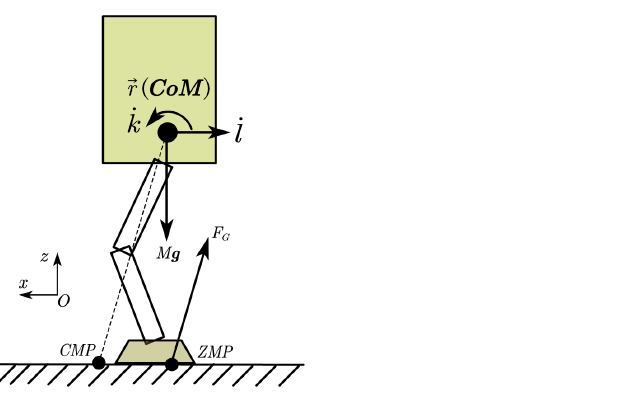
Figure 1. External forces analysis. In the xOz plane, the robot is subjected to gravity force, ground reaction force, and the inertial force of its own